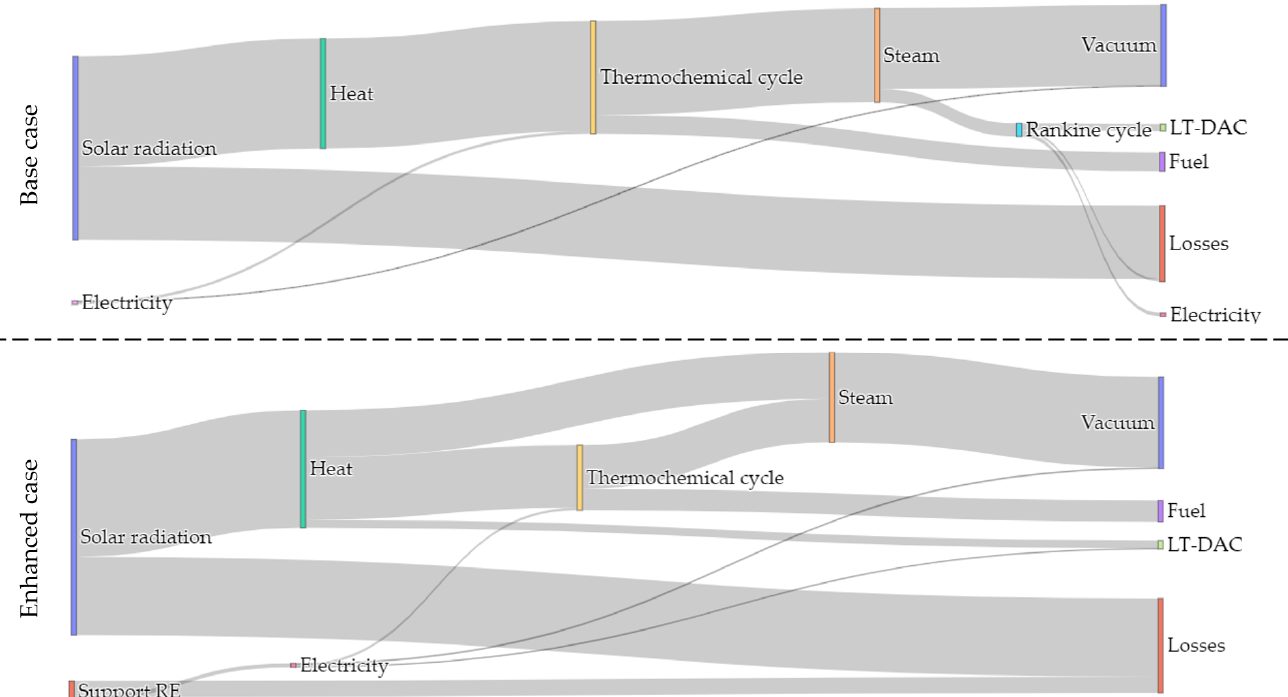
Figure 14. Sankey diagrams for Scenario C in the base case (P O2 = 5 × 10 − 4 bar, upper plot) and in the enhanced case (P O2 = 1 × 10 − 6 bar, lower plot). The term “Support RE” stands for support renewable energy (e.g., PV).